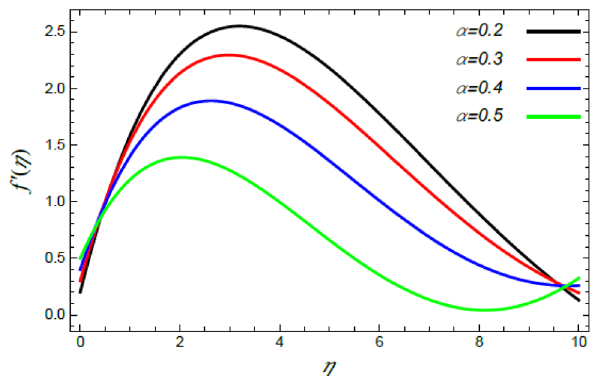
Figure 6. Deviation of the radial speed f ′ (η) versus η as given in Eq. (64) to illustrate the influence of the stretching factor α .